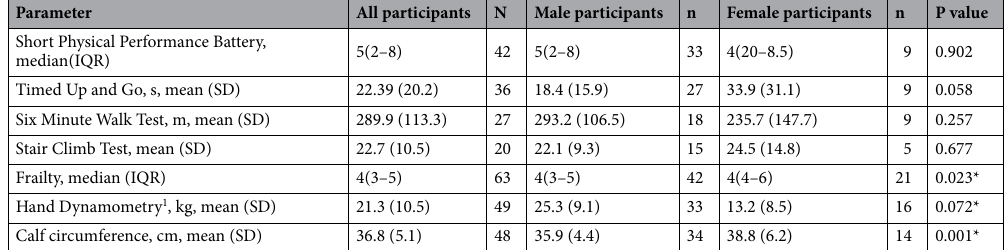
Hand Dynamometry 1 , kg, mean (SD) 21.3 (10.5) 16 0.072* Calf circumference, cm, mean Table 2. Summary of physical performance measures. 1 average of right and left sides, *p < 0.05.